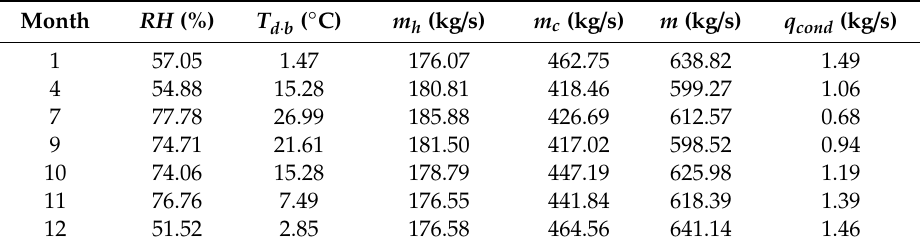
Table 4. Specific operation parameters during typical months (N = 8, G = 2000 m 3 /